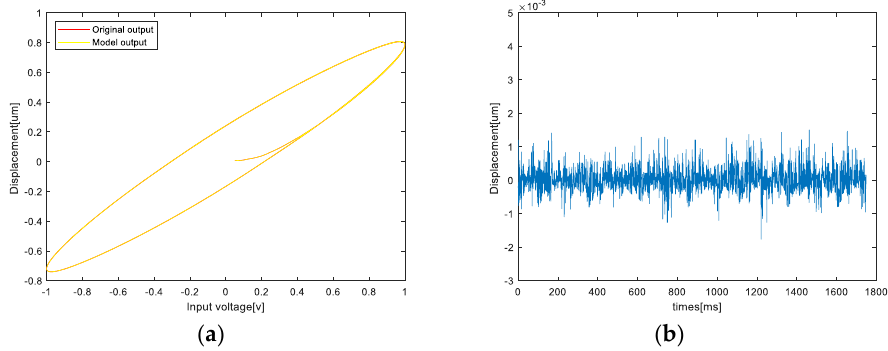
Figure 8. When the input frequency f = 40 Hz: ( a ) hysteresis model; ( b ) modeling